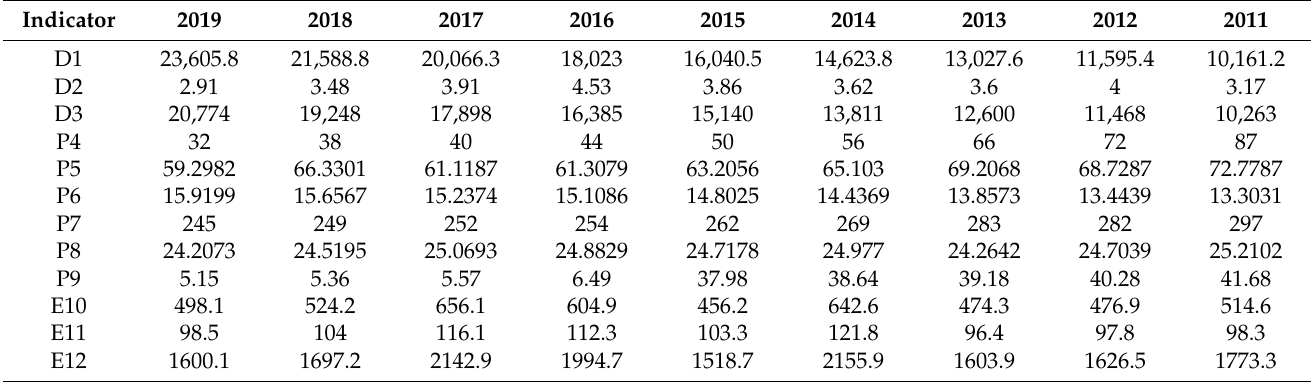
Table 4. The raw data of Chongqing water urban water security evaluation index (2011–2019).